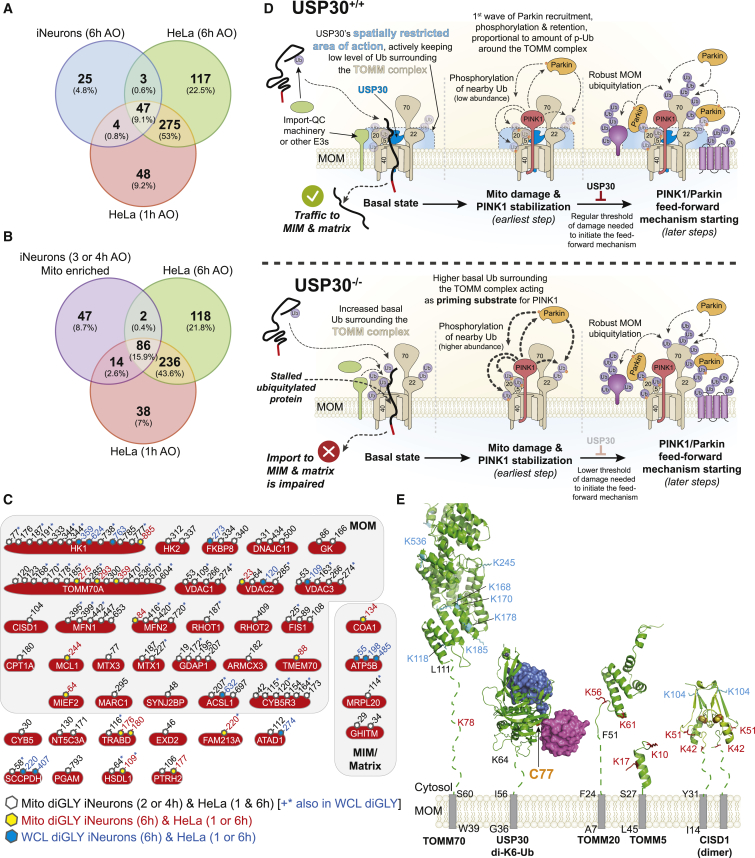
Landscape of Parkin-Dependent Ubiquitylation and USP30-Dependent Deubiquitylation on Mitochondria in iNeurons(A) Venn diagram of overlapping diGLY sites observed in whole-cell lysates (WCLs) (6 h post-depolarization) from iNeurons and sites observed for purified mitochondria for HeLa cells 1 or 6 h post-depolarization. All peptides used were increased by at least 1-fold (log2 ratio > 1.0), with p < 0.05.(B) Venn diagram of overlapping diGLY sites observed in purified mitochondria (3 and/or 4 h post-depolarization) from iNeurons and sites observed for purified mitochondria for HeLa cells 1 or 6 h post-depolarization. All peptides used were increased by at least 1-fold (log2 ratio > 1.0), with p < 0.05.(C) Diagram showing the sites of ubiquitination in 41 proteins identified as high-confidence Parkin substrates in iNeurons and the corresponding identifications in previously reported data using HeLa cells ectopically expressing Parkin with a parallel TMT-MS3 platform (Rose et al., 2016). Residue numbers for diGLY modified Lys residues are shown. Black font and open hexagon, diGLY site found in purified mitochondria from iNeurons (3 and/or 4 h post-depolarization; Table S2) and in purified mitochondria from HeLa cells (1 or 6 h post-depolarization). Sites in black font also noted by the blue asterisk were also found in whole-cell lysates from iNeurons (6 h post-depolarization; Table S1). Red font and yellow hexagon, diGLY site found in purified mitochondria from iNeurons (3 and/or 4 h post-depolarization; Table S2) and in purified mitochondria from HeLa cells depolarized for 1 or 6 h. Blue font and blue hexagon, diGLY site found in whole-cell lysates from iNeurons (6 h post-depolarization; Table S1) and in purified mitochondria from HeLa cells depolarized for 1 or 6 h.(D) Model for USP30-dependent mitochondrial protein deubiquitylation.(E) Structural constraints for USP30-dependent removal of Ub from MOM proteins. Transmembrane segments, gray rectangles. Membrane proximal linkers, dotted lines. Sites of ubiquitylation (red) are those that are reversed by USP30 under depolarization conditions, while those in cyan are largely unchanged in USP30−/− cells. USP30 catalytic cysteine, yellow. TOMM70, modeled on S.c. Tom70, PDB: 2GW1; USP30 in complex with K6-di-Ub, PDB: 5OHP; CISD1 model, PDB: 3EW0; TOMM5 model, PDB: 3PRM; TOMM20 model, PDB: 1OM2.See also Figure S7 and Tables S1 and S3.